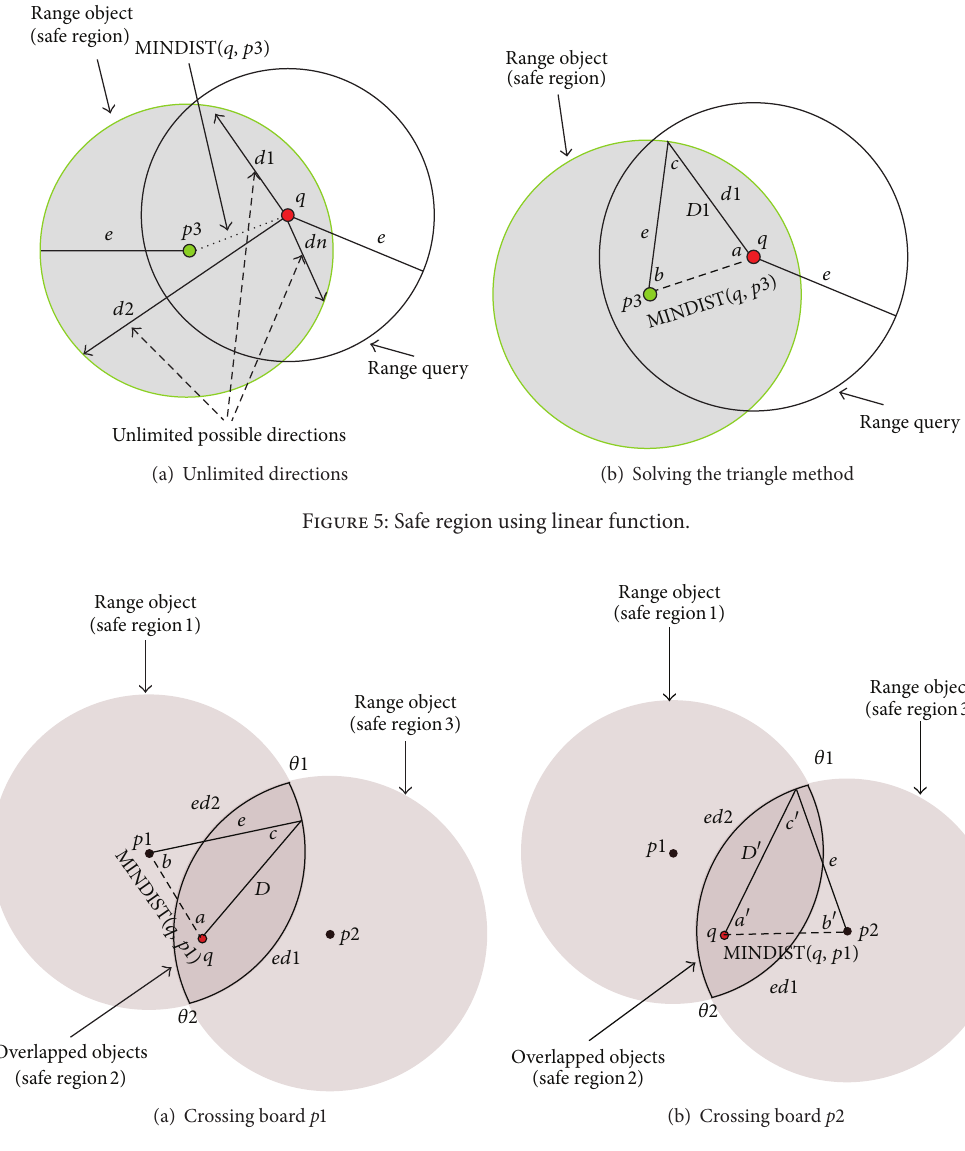
Figure 6: Monitoring 𝑞 within range of two